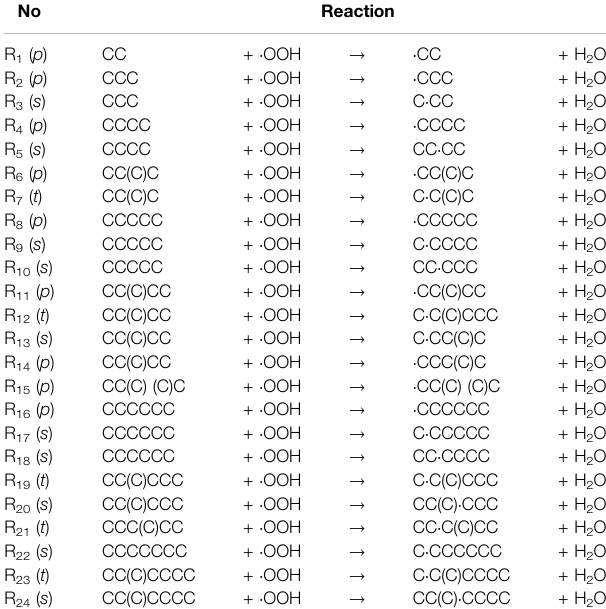
TABLE 1 | Processes selected to the representative (training) set for the alkyl + · OOH → alkyl radical + H “ p ” represents H abstraction 2 O 2 reaction class; by · OOH radical from a primary C atom (type p ), “ s ” and “ t ” from secondary and tertiary ones. Both reactants and products are represented with SMILES linear